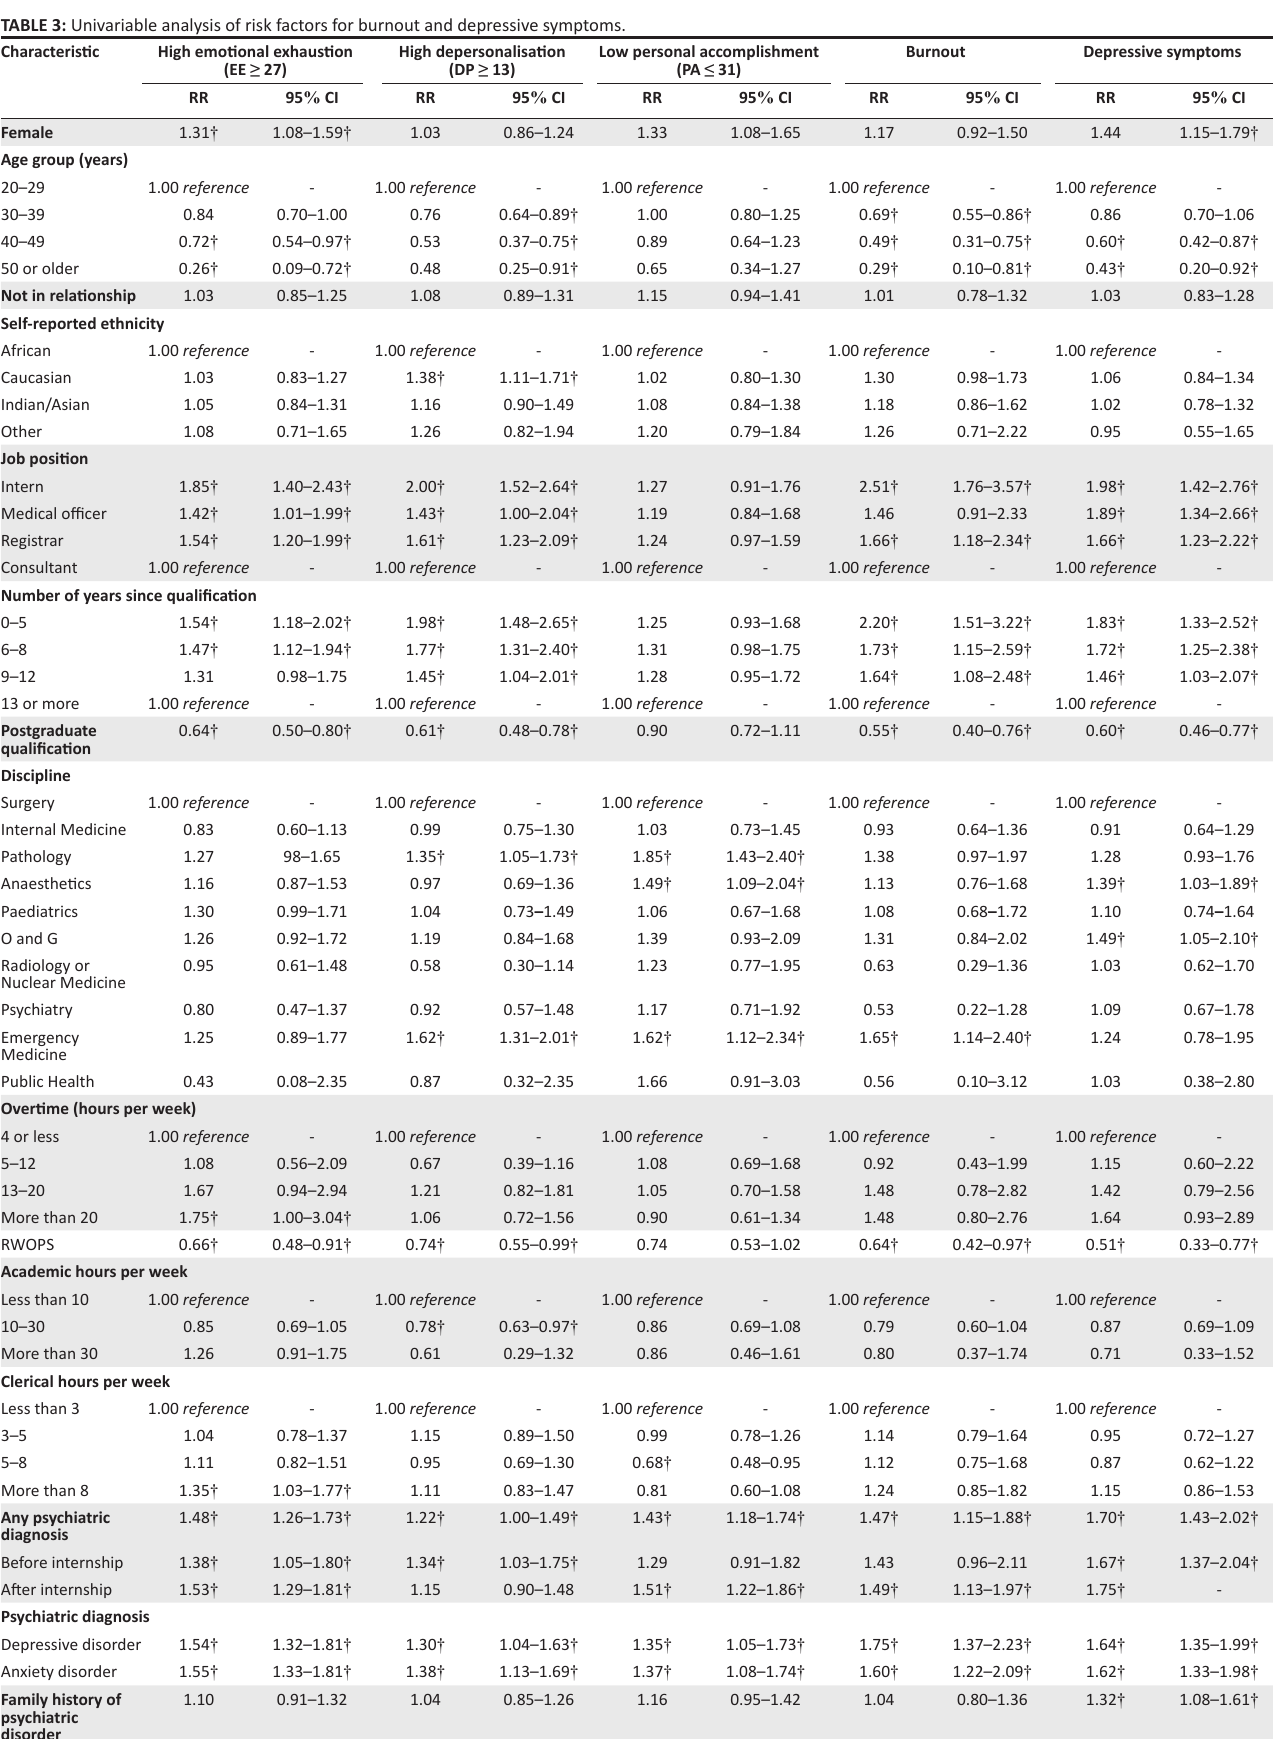
TABLE 3: Univariable analysis of risk factors for burnout and depressive symptoms.